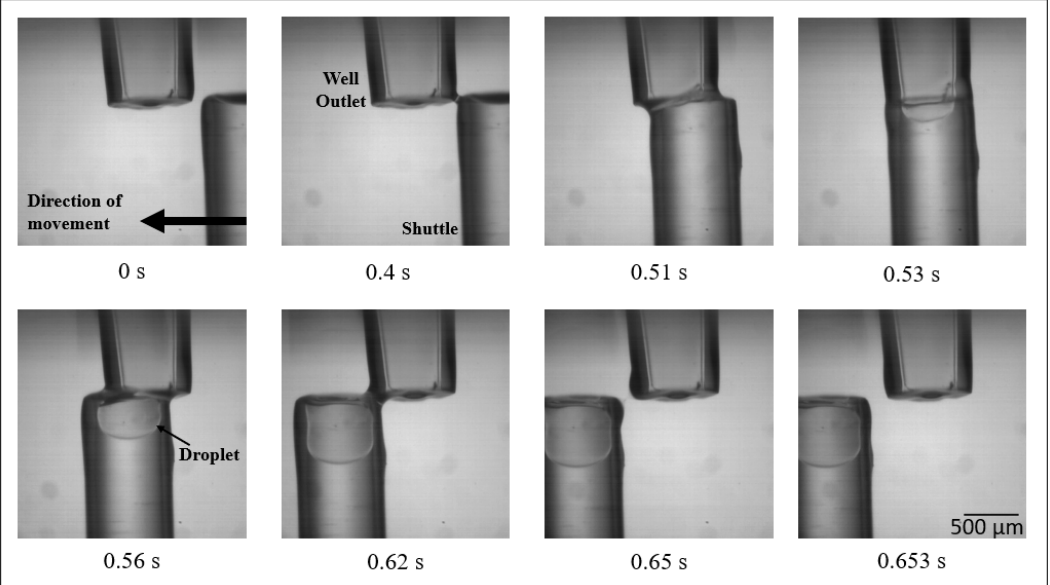
Figure 2. Gap Switch Technology (GST), Droplet Generation and Mixing. High-speed camera images taken of the GST. Images were taken using an IDT X-Stream XS-4 CMOS Camera at 1000 frames per second. The droplets are completely surrounded by silicone oil and therefore never contact a solid surface. This eliminates carry-over contamination and makes the system continuously reusable. Shuttle velocity is approximately 4mm/s. The dispensed droplet can be seen in the lower tube. The tubing is PTFE which attracts the oil and repels the aqueous, hence the wrapped droplets.